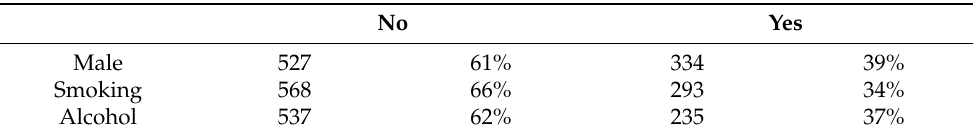
Figure 1. Age and sex distribution of study participants. Table 1. Descriptive data of participants of the